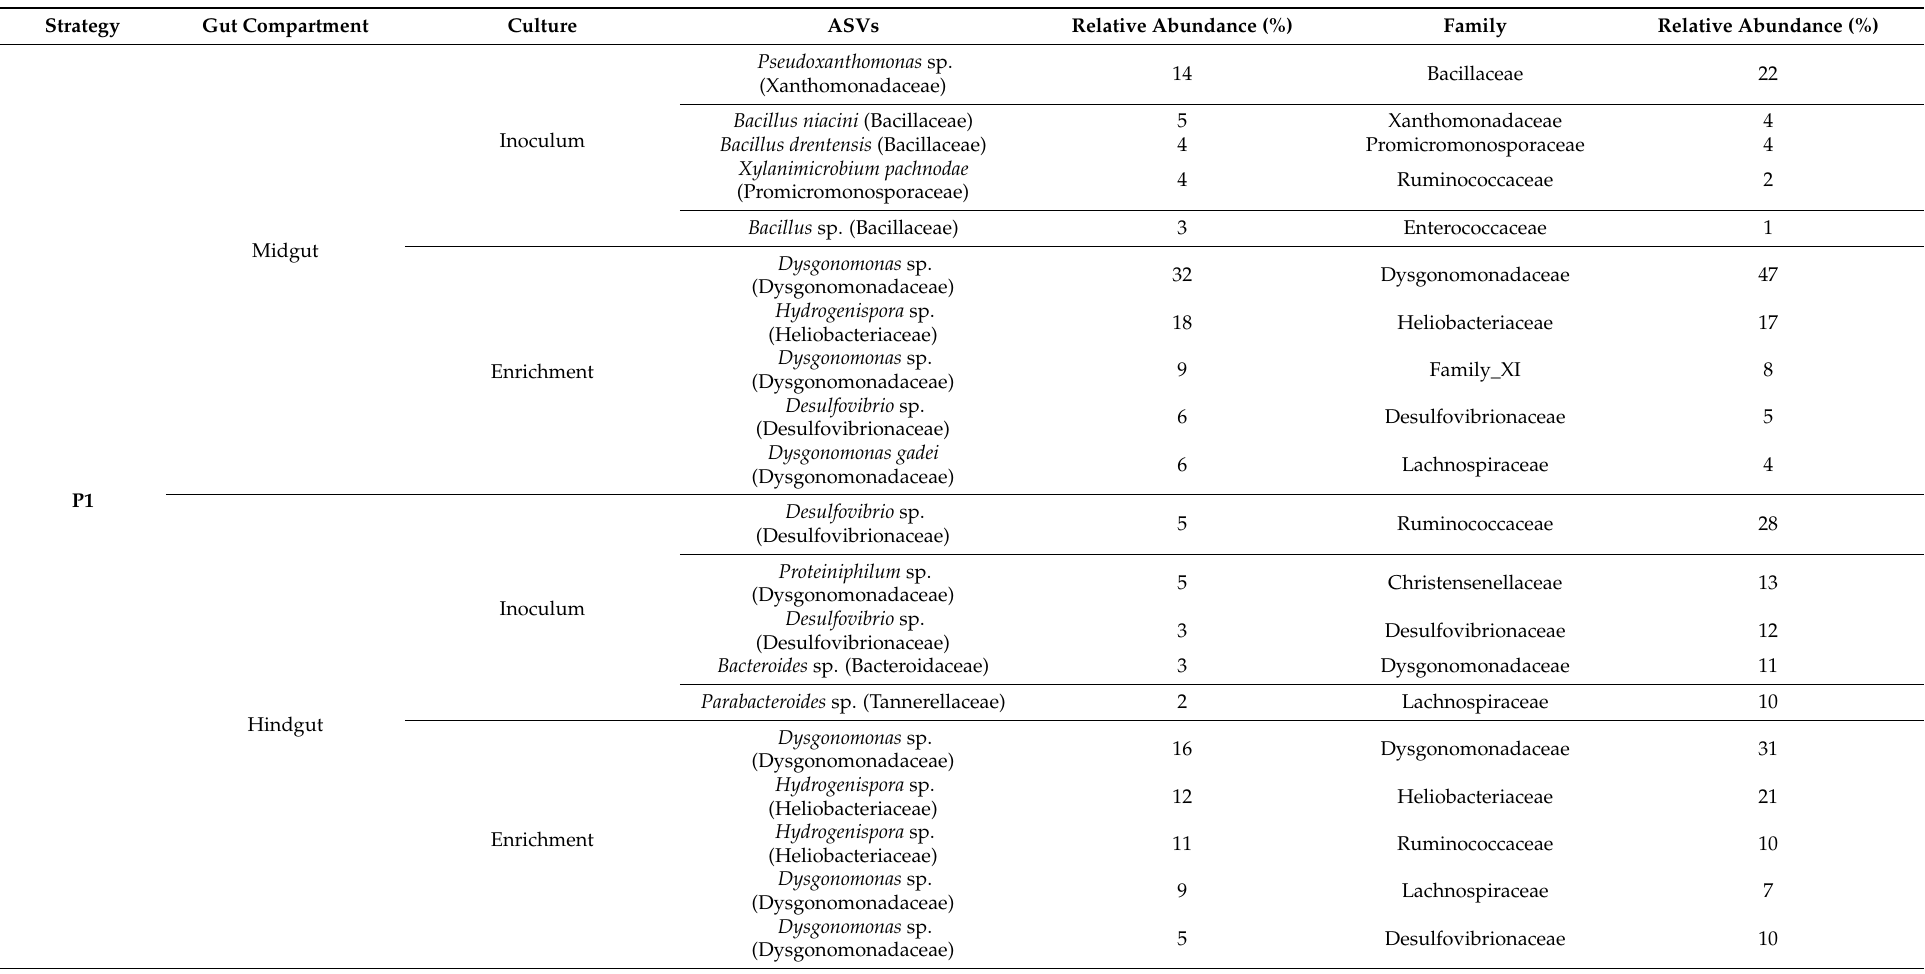
Table 1. Summary of the top 5 most abundant ASVs and families in the midgut and hindgut, procedure 1 (3T), procedure 2 (6T) and inoculum samples. The relative abundance of n = 3 was